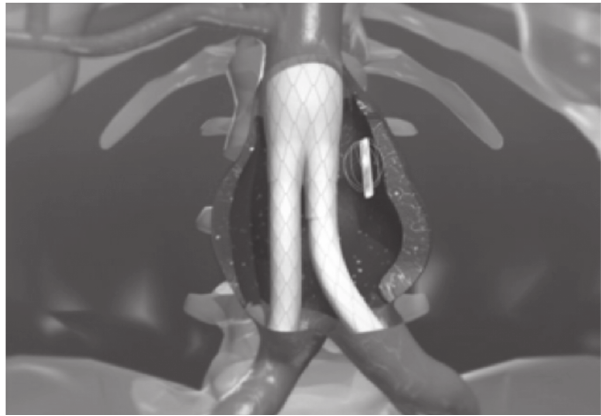
Figure 4 – Visualization of the EndoSure TM wireless pressure sensor after sac exclusion by the